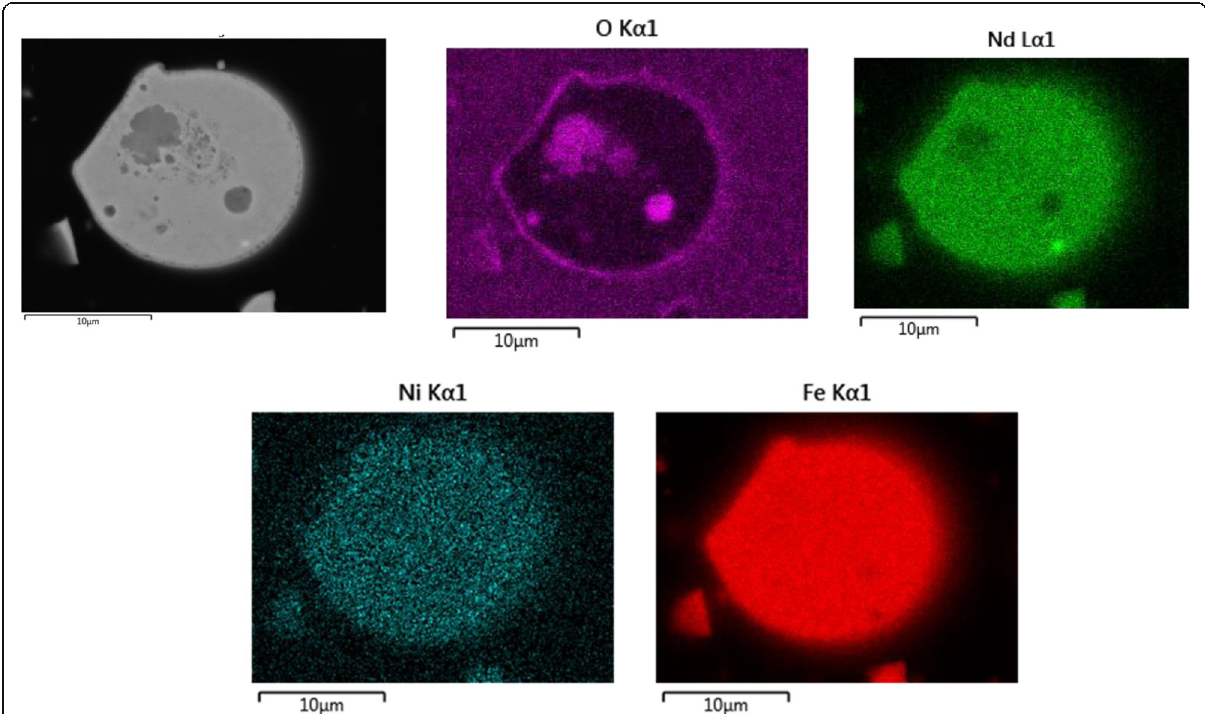
Fig. 15 Map analysis performed by EDX of the magnetic particle on the PEEK_50NdFEB